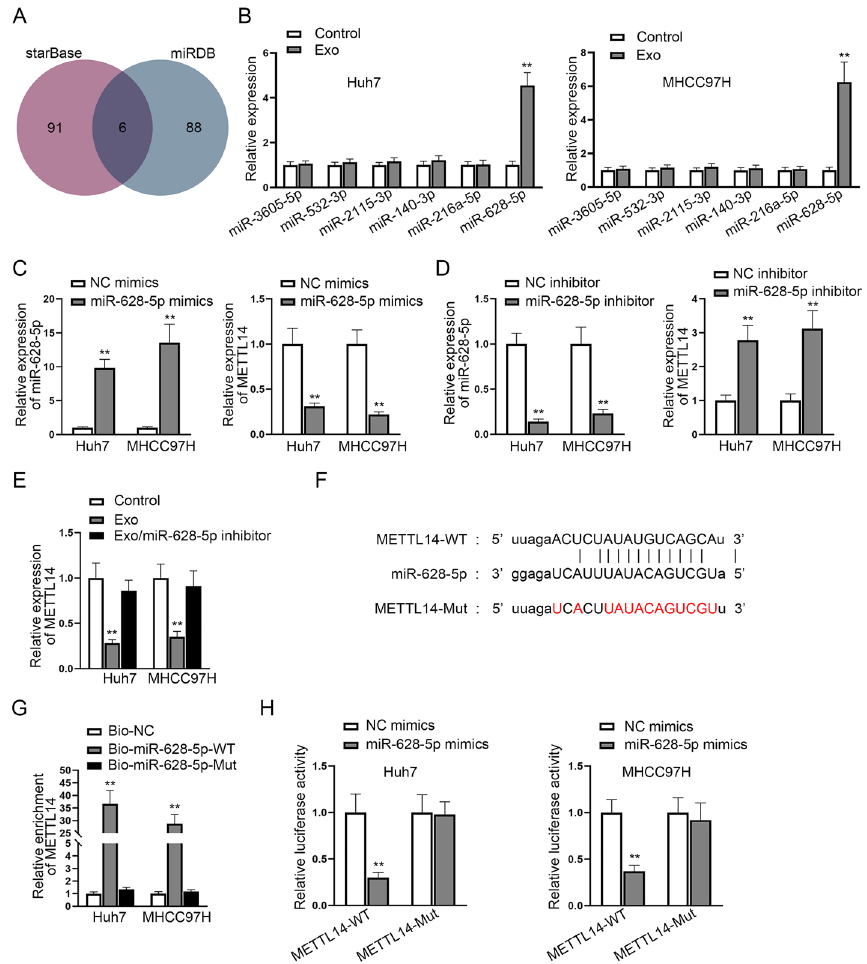
Fig. 6 M1-Exo transferred miR-628-5p to inhibit METTL14 expression in HCC. A Potential miRNAs in the upstream of METTL14 were selected through bioinformatic predictions. B The expression of potential miRNAs following M1-Exo treatment was tested. C , D MiR-628-5p expression was enhanced or silenced in HCC cells, and then the expression of METTL14 was analyzed by RT–qPCR. E METTL14 expression was measured under different conditions. F The binding sites between METTL14 and miR-628-5p were forecast through starBase. G An RNA pull down assay was conducted to evaluate the enrichment of METTL14 in wild type or mutated bio-miR-628-5p groups. H The luciferase activity of HCC cells transfected with miR-628-5p mimics in the wild type or mutated METTL14 groups. In relevant assays, data in the experimental group was statistically significant in comparison with the negative control group ( P value <